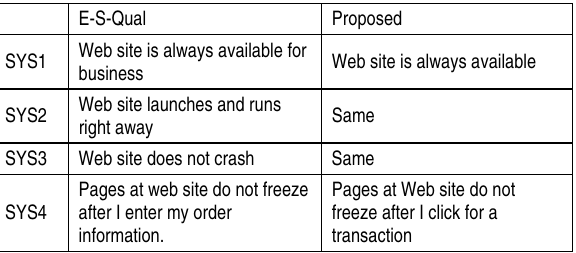
Table 4. System availability questions (SYS)